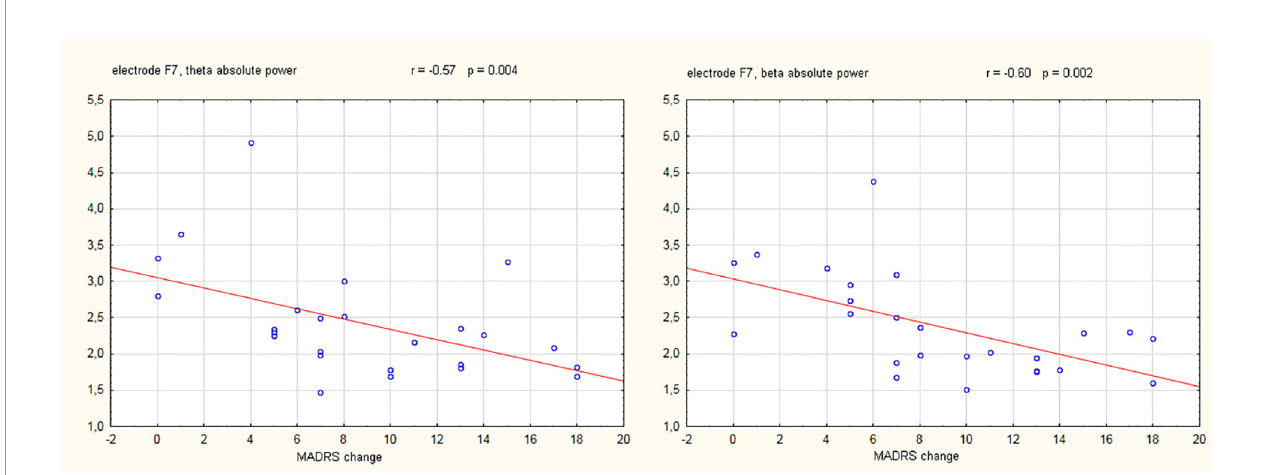
FIGURE 1 | Scatterplots showing electroencephalography (EEG) absolute power values (µV2) in the theta and beta frequency band against the change of Montgomery-Åsberg depression rating scale (MADRS) score (baseline - week 4). The Pearson correlation coef fi cients (with corresponding p-values) for the relation between MADRS change and EEG power are also shown.